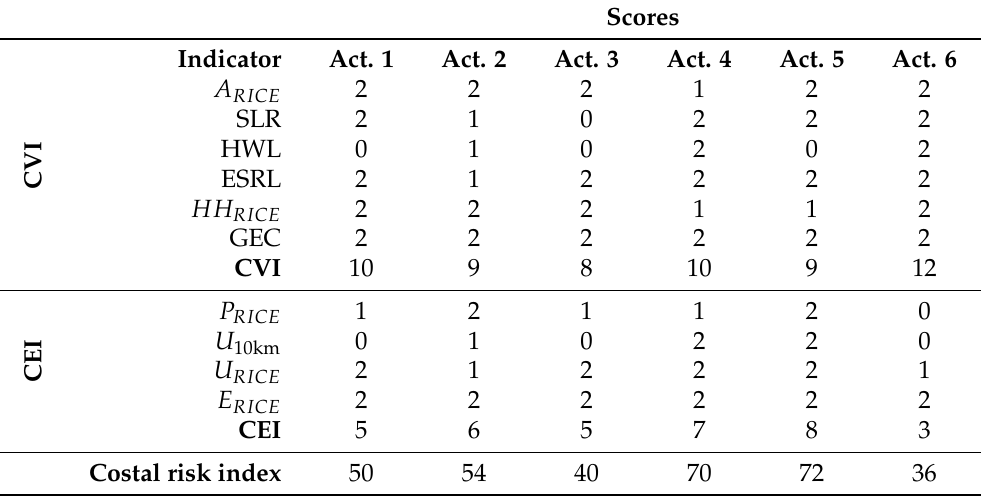
Table 3. Perceived Coastal Risk Index by stakeholders and policy makers in